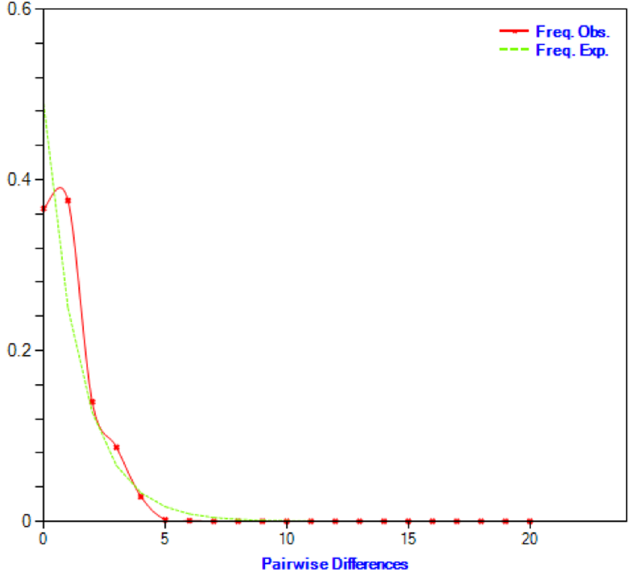
Fig. 3. Mismatch distribution for COI-based pairwise distances of the North-Western Red Sea and Bitter lakes ’ populations of P. semisulcatus.